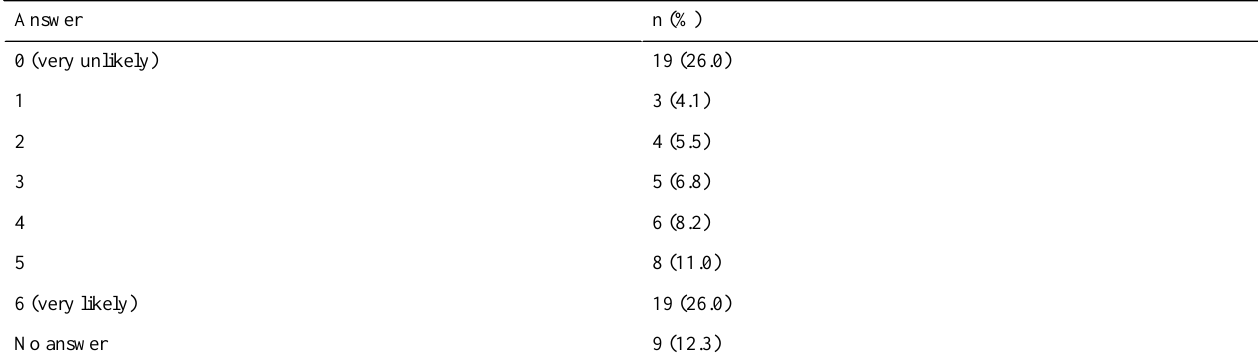
Table 15. Parents’answers about the probability (0 [very unlikely] to 6 [very likely]) of enrolling their children in the community